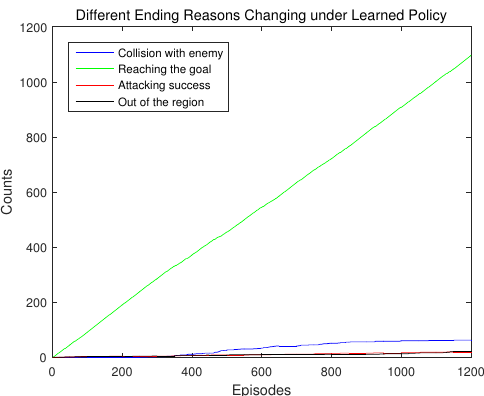
Figure 15. The numbers of different ending reasons when using the policy learned with the Sarsa based